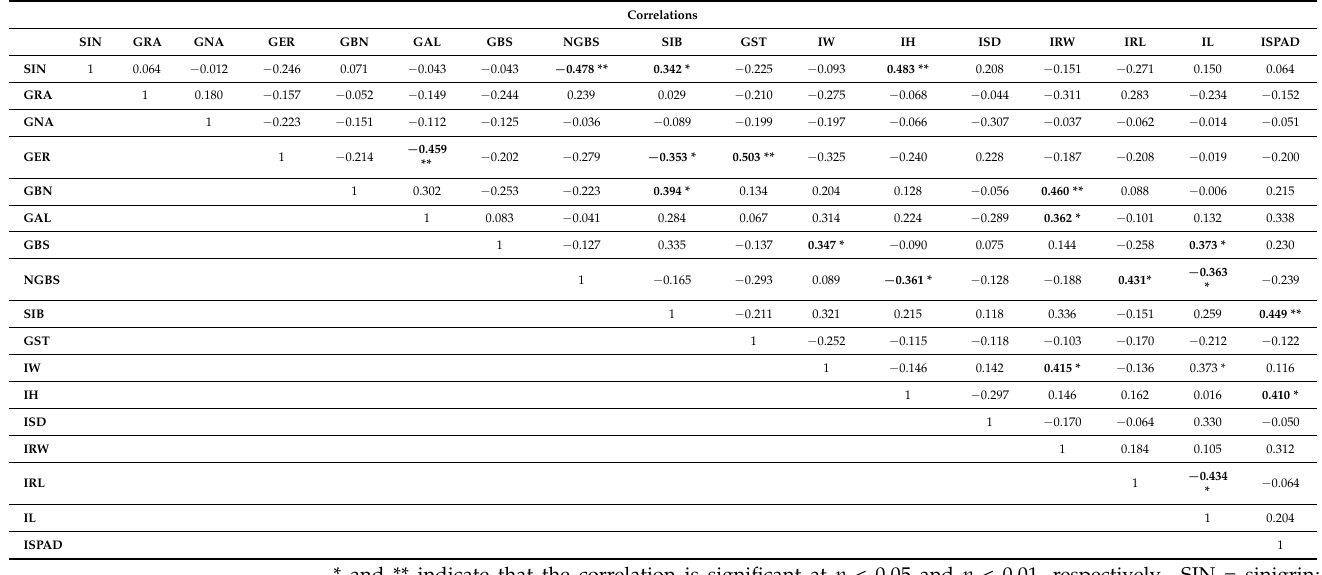
Table 5. Pearson’s correlation coefficients among the individual and total GLSs (detected in the leaves in NIR) and the index of morphometric traits identified in the studied crops.